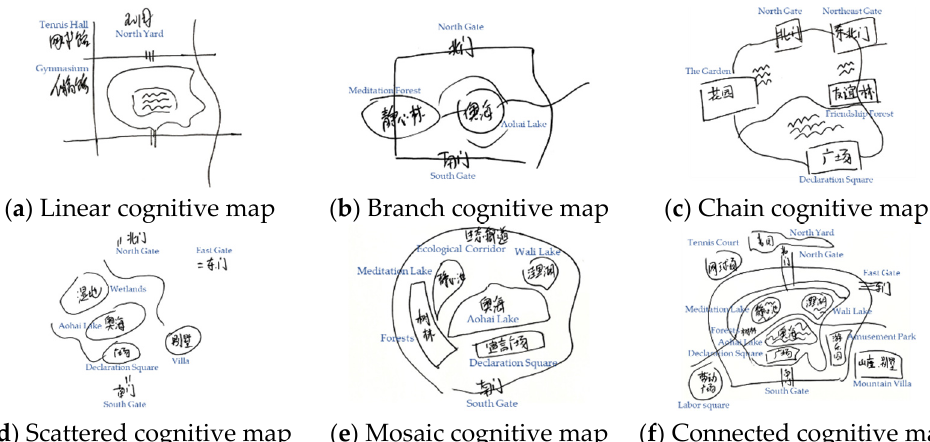
Figure 4. Examples of hand-drawn cognitive maps from this study.